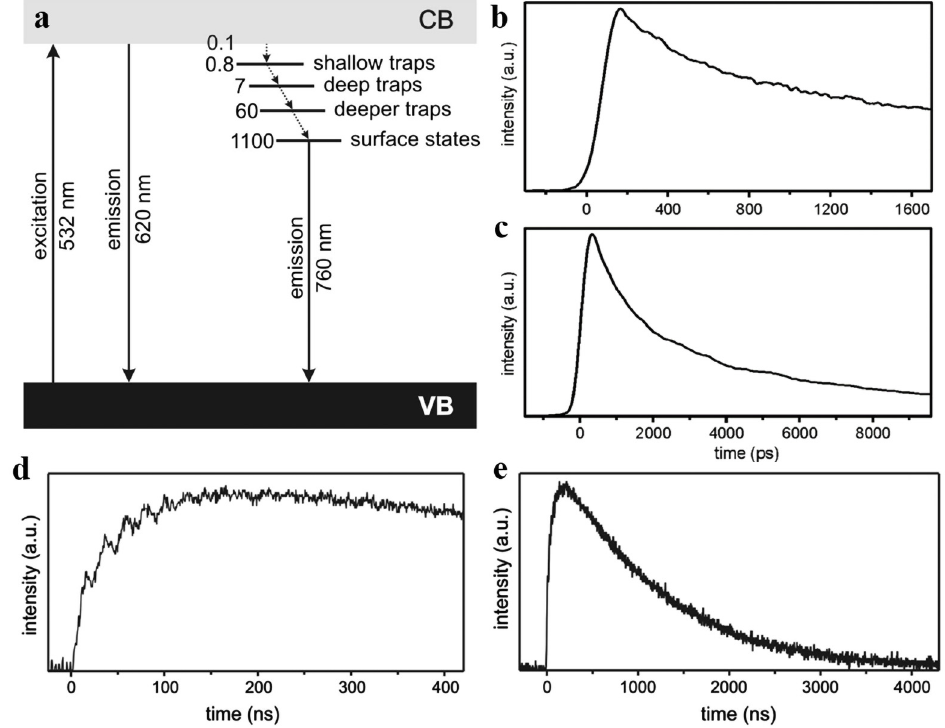
Figure 4. ( a ) Schematic diagram for the luminescence relaxation kinetics of core–shell InP@ZnSe quantum dots dispersed in n-hexane. All the time, constants are given in units of nanoseconds. Picosecond luminescence kinetic profiles were measured in short ( b ) and long time ( c ) windows of core–shell InP@ZnSe nanoparticles dispersed in n-hexane, and the sample was excited at 532 nm and monitored at 600 nm. Nanosecond luminescence kinetic profiles were measured in short ( d ) and long time ( e ) windows of core–shell InP@ZnSe nanoparticles dispersed in n-hexane, and the sample was excited at 532 nm and monitored at 800 nm. Reprinted with permission from Ref. [65]. © 2010, Elsevier Inc.